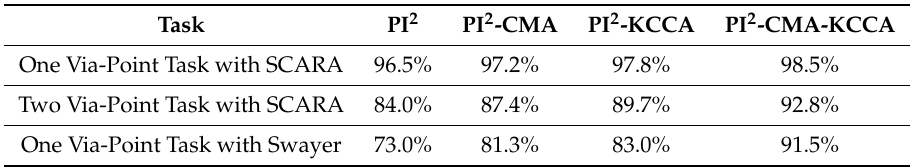
Table 5. Average decline rate of four